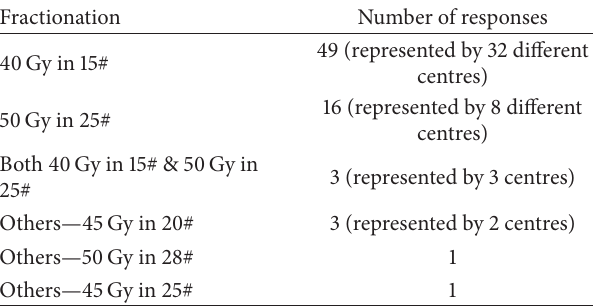
Table 1: Choice of